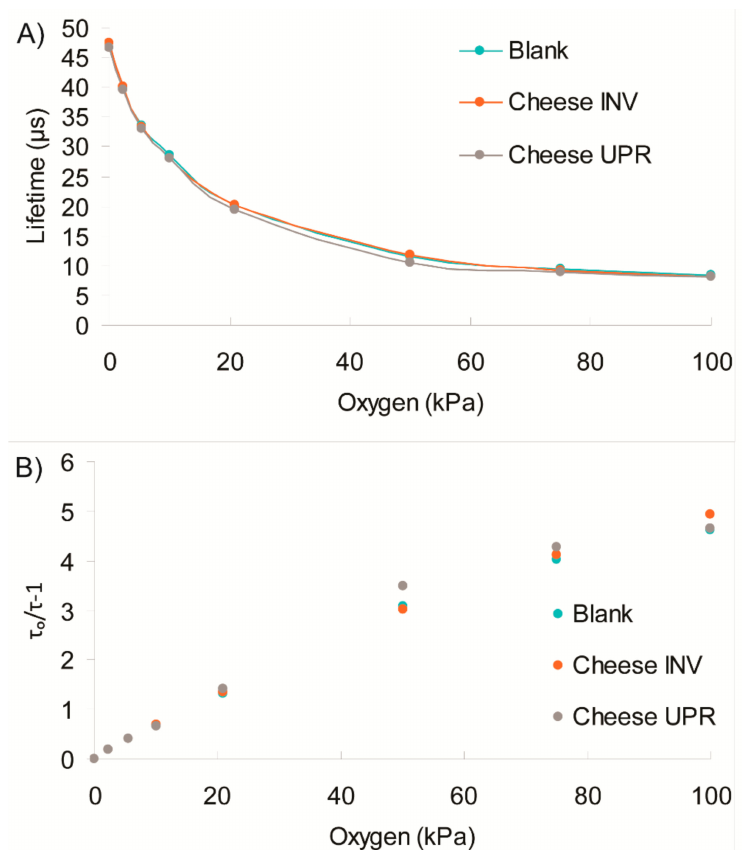
Figure 5. Lifetime calibration curves ( A ); and corresponding Stern–Volmer plots ( B ) for Type 2 sensors after incorporation in cheese packs. Measured at 20 ◦ C, 0–100 kPa dry O 2 gas.